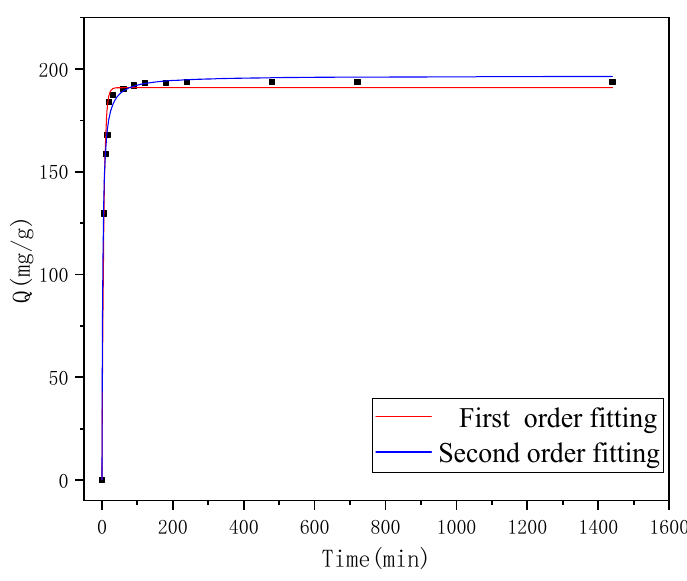
Figure 9. The adsorption kinetics of FCF on γ -Fe 2 O 3 @GMA@IM.